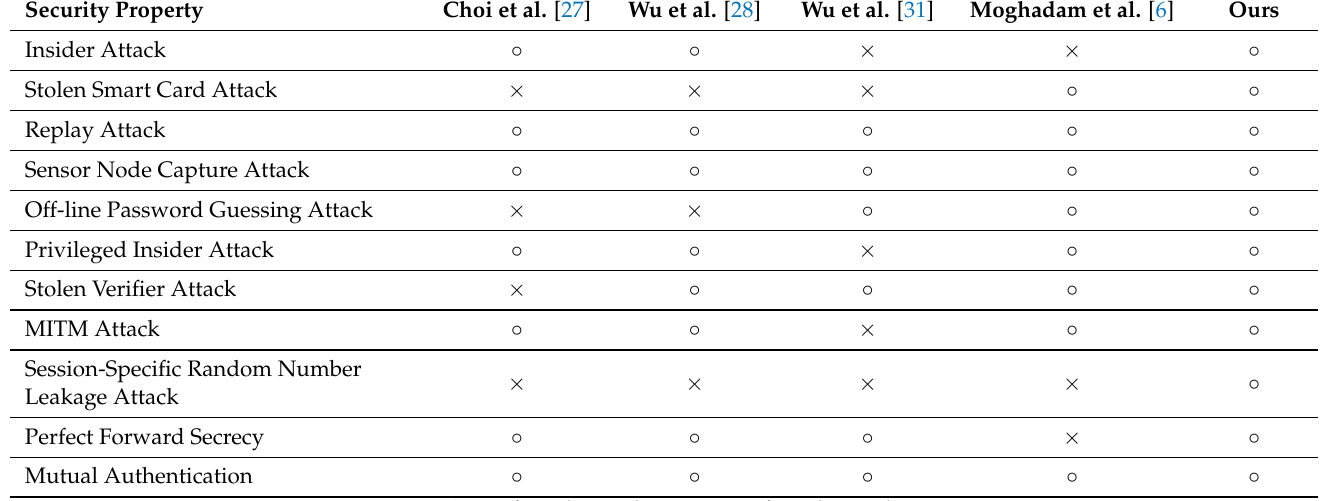
Table 5. Security